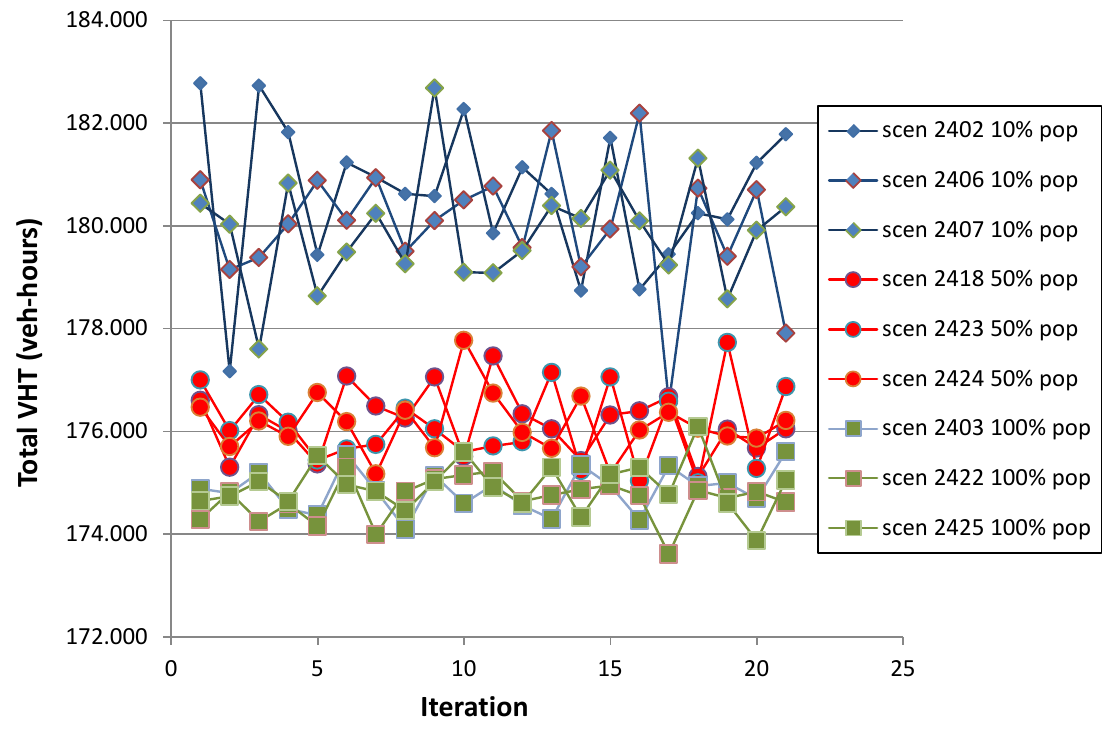
Figure 16. Variations of VHT for different population sample